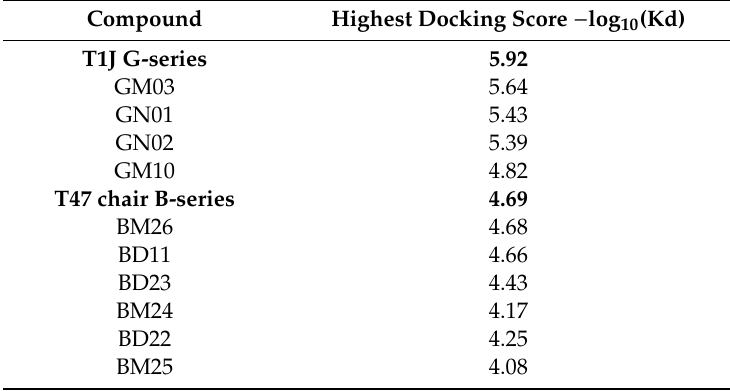
Table 3. Docking Scores of T47 and T1J derivatives with halogen